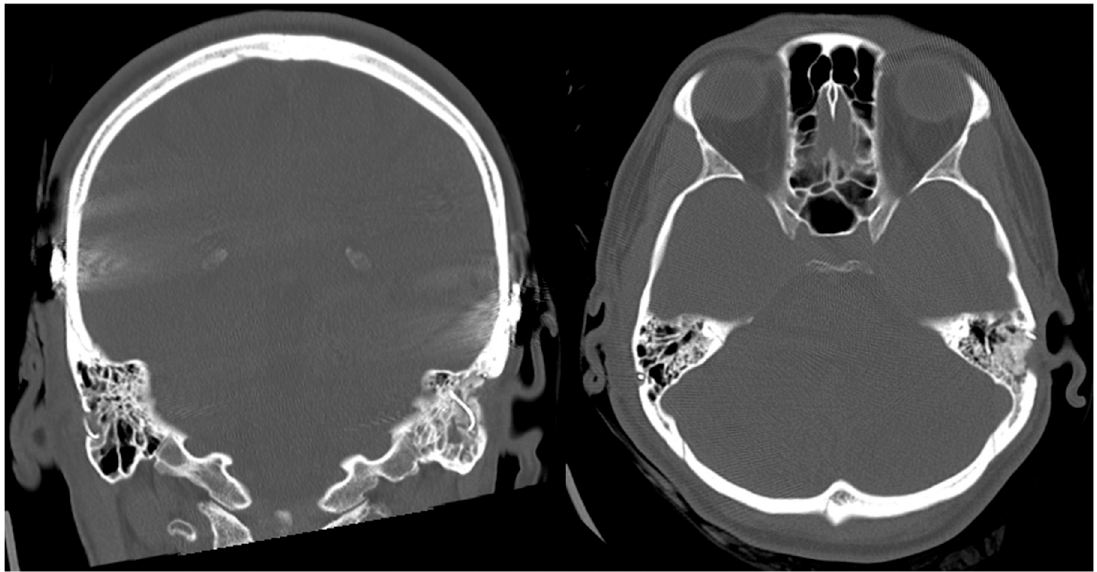
Figure 6. Coronal and axial sections of a CT scan of the post-operative period.